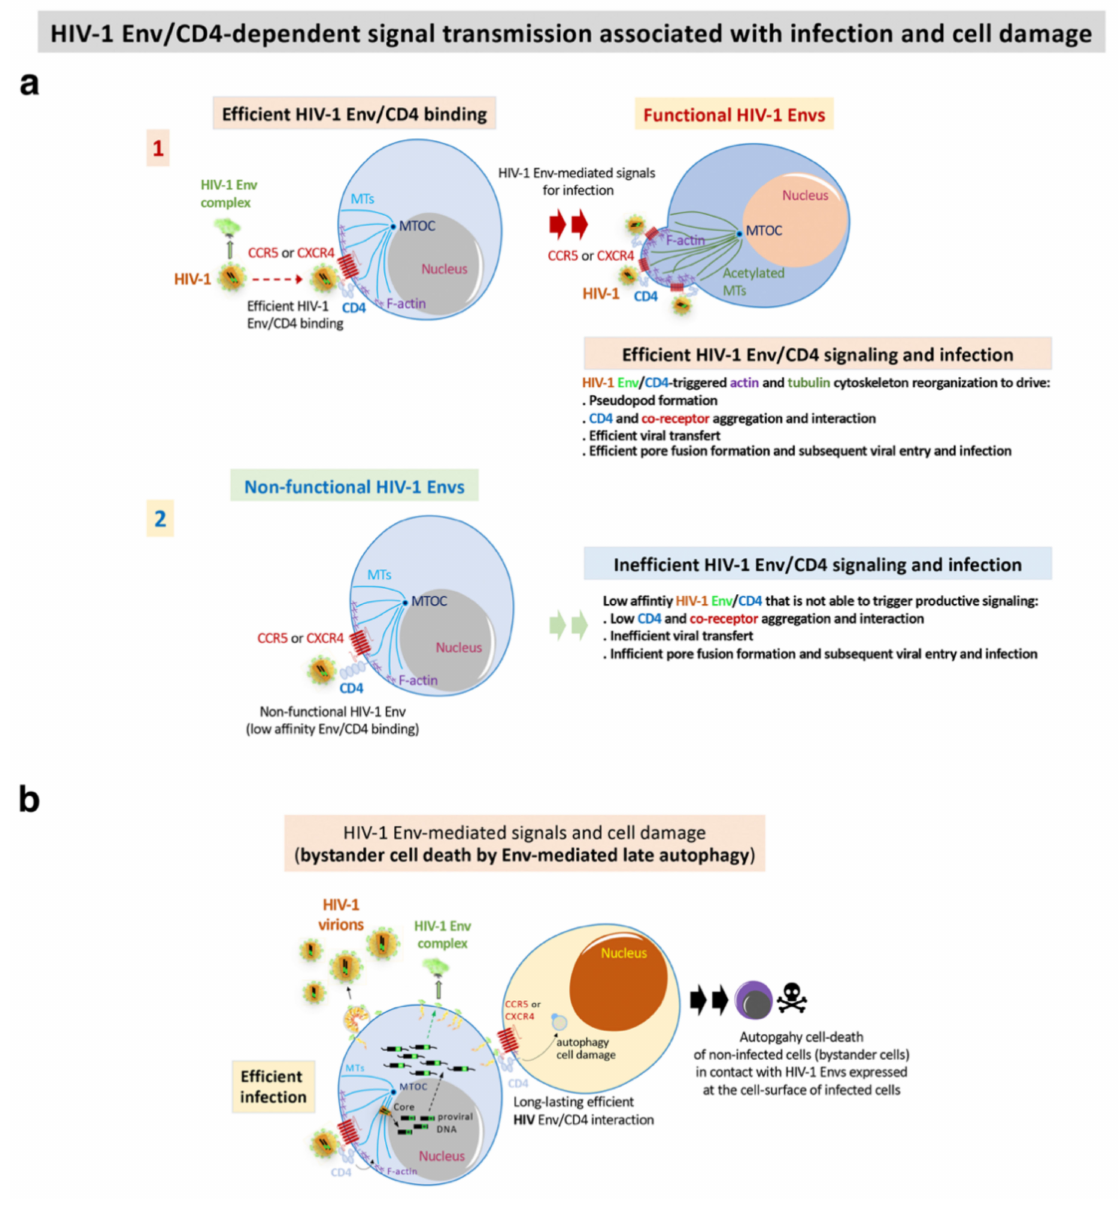
Figure 3. HIV-1 Env-mediated productive cell signals and cell damage: ( a ) functional HIV-1 Envs of viral isolates from progressors (progressors and RPs) and viremic (VNPs) patients efficiently binds to CD4 for the promotion of the F-actin and MTs reorganizations and post-translational modifications. This signal drives pseudopod formation in CD4+ T cells where CD4 and chemokine co-receptors for HIV-1 infection reorganize, aggregate and interact (step 1) [70,72,121,123,125,126,140,142]. These events are required for efficient pore fusion formation, viral transfer, virus entry and infection. On the contrary, non-functional HIV-1 Envs of viral isolates from non-progressors’ patients (LTNP- ECs, LTNPs and vLTNPs) are not able to bind to CD4 with high affinity, and thereby are unable to reorganize the cytoskeleton and favour all the events for productive viral transfer and infection (step 2) [70,72,121]; ( b ) functional HIV-1 Envs of viral isolates from viremic and progressors (VNPs and RPs) patients efficiently bind to CD4 to trigger late autophagy with subsequent cell death of non-infected CD4+ T cells (bystander cells) by contact